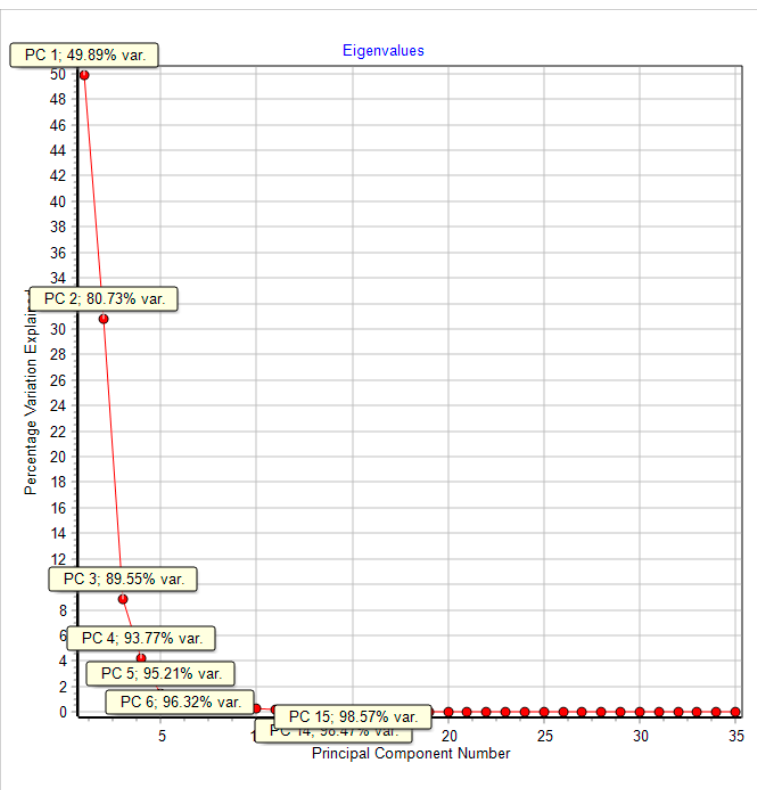
Figure 8. Eigenvalues plot explaining how the data variance is described by the most relevant principal components (PCs).